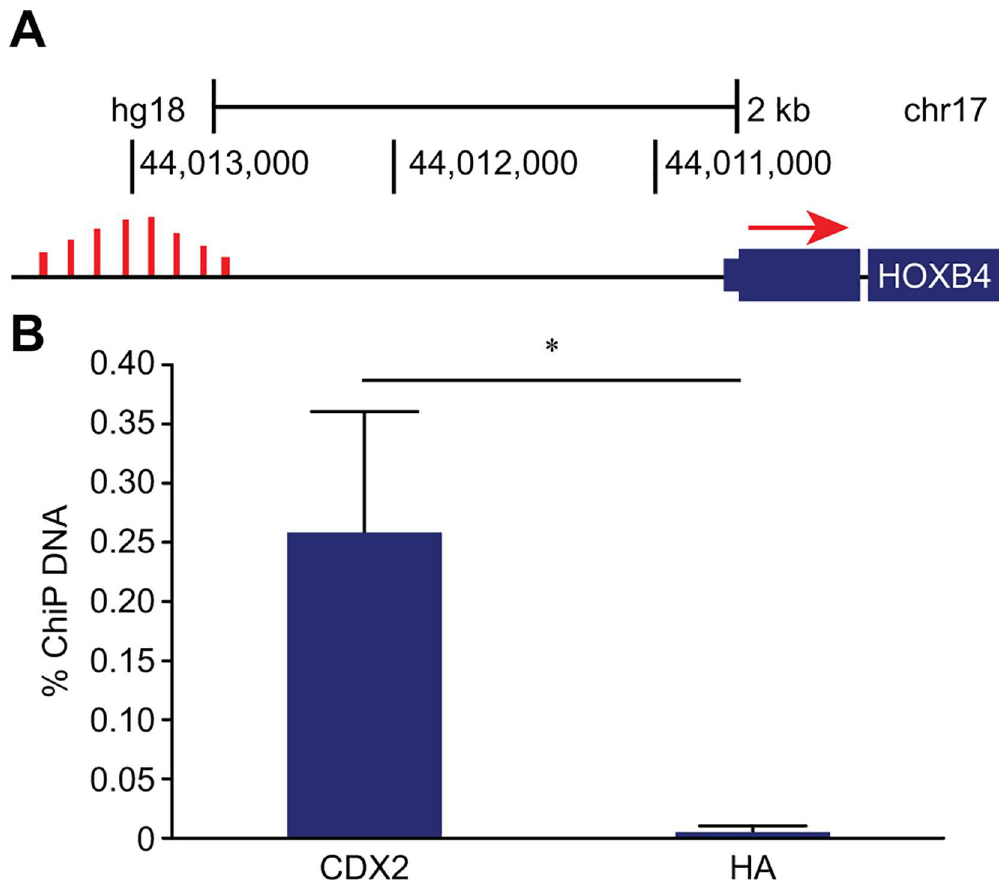
Fig 1. Illustration of the CDX2 binding region in the HOXB4 enhancer region and analysis of CDX2 interactions with the HOXB4 enhancer region. Fig 1A) Genome browser CDX2 ChIP-seq peaks from a dataset generated by Boyd et al.[17]. Fig 1B) ChIP-PCR with primers covering the CDX2 bindingregion within the HOXB4 enhancer. Equal amounts of input DNA were used for CDX2 ChIP-PCR. Hemagglutinin (HA) was used as a negative control. The mean (n = 4) and SD are shown. * P <